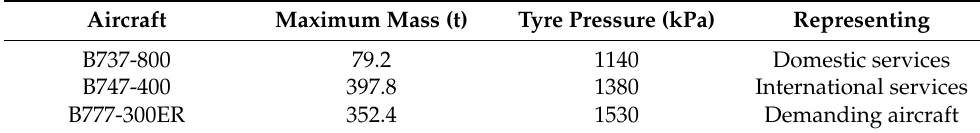
Table 1. Aircraft